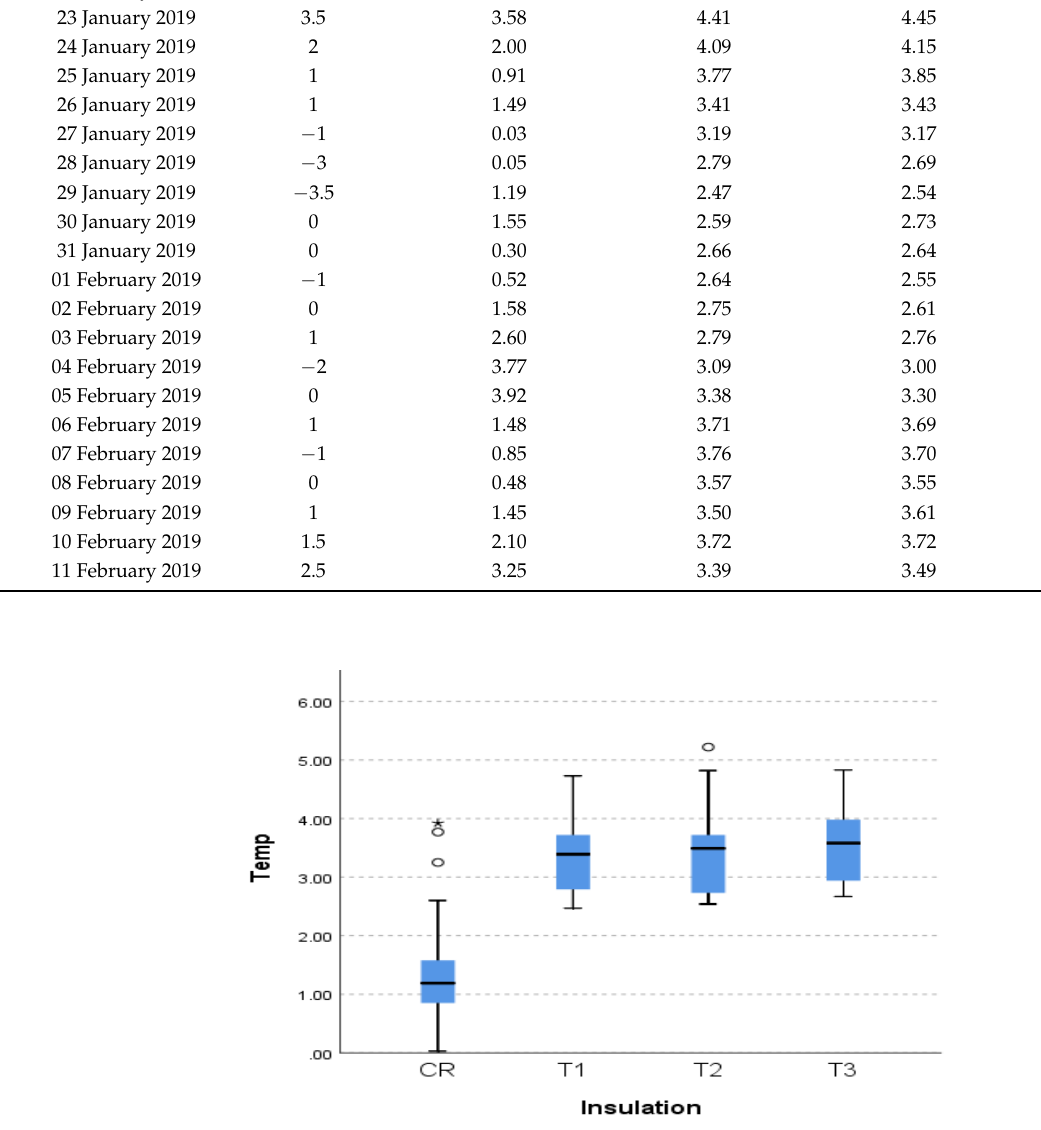
Figure 7. Independent sample Kruskal–Wallis